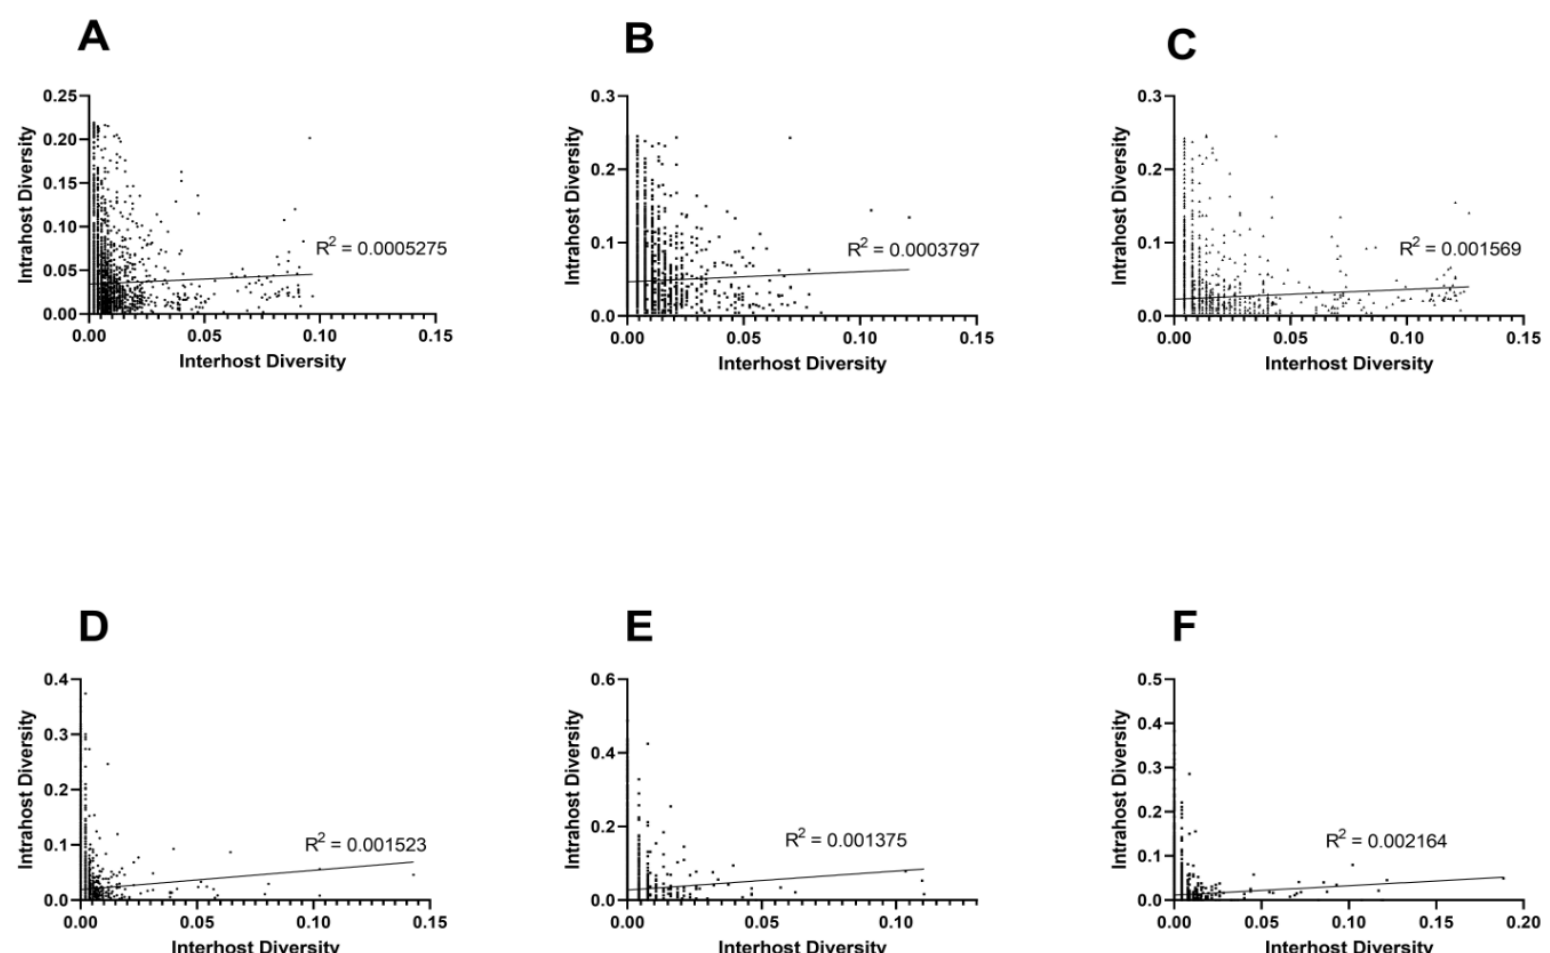
Figure 4. Weak correlation between inter and intrahost genetic diversity (S n ) of WNV within all hosts ( A , D ), avian ( B , E ), and mosquito hosts ( C , F ) for NT S n shown in panels A-C and AA S n shown in panels D-F. Linear regression analysis was performed on each data set, and the resulting R 2 is shown. A Spearman’s rank correlation was also performed in each case, indicating weak but statistically significant ( p < 0.05) relationships for each data set.